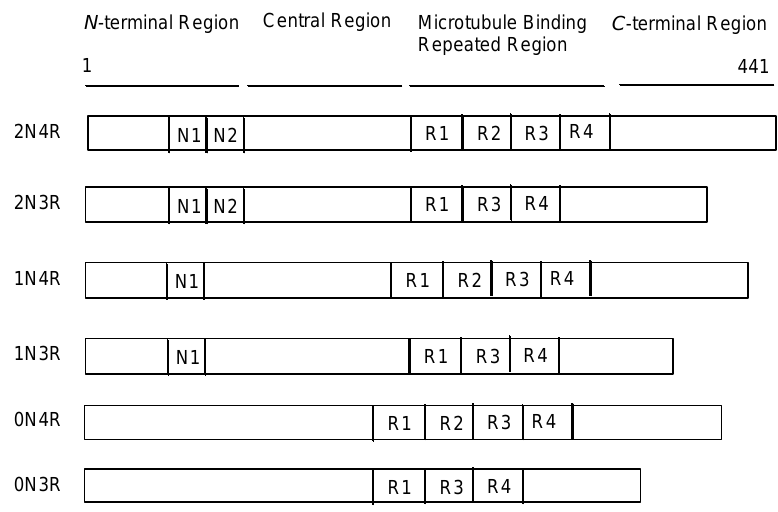
Figure 3. Schematic representation of the protein structures of tau.